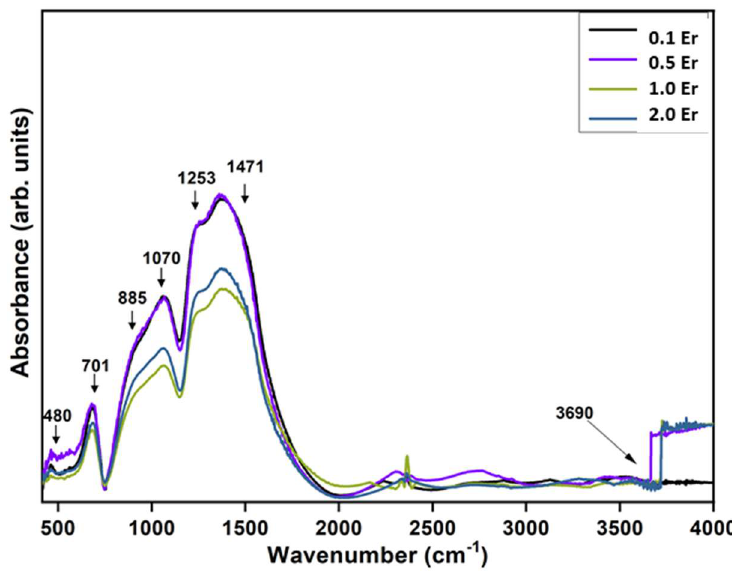
Figure 2. FT-IR spectral results of studied Er 2 O 3 doped ZBB glasses.